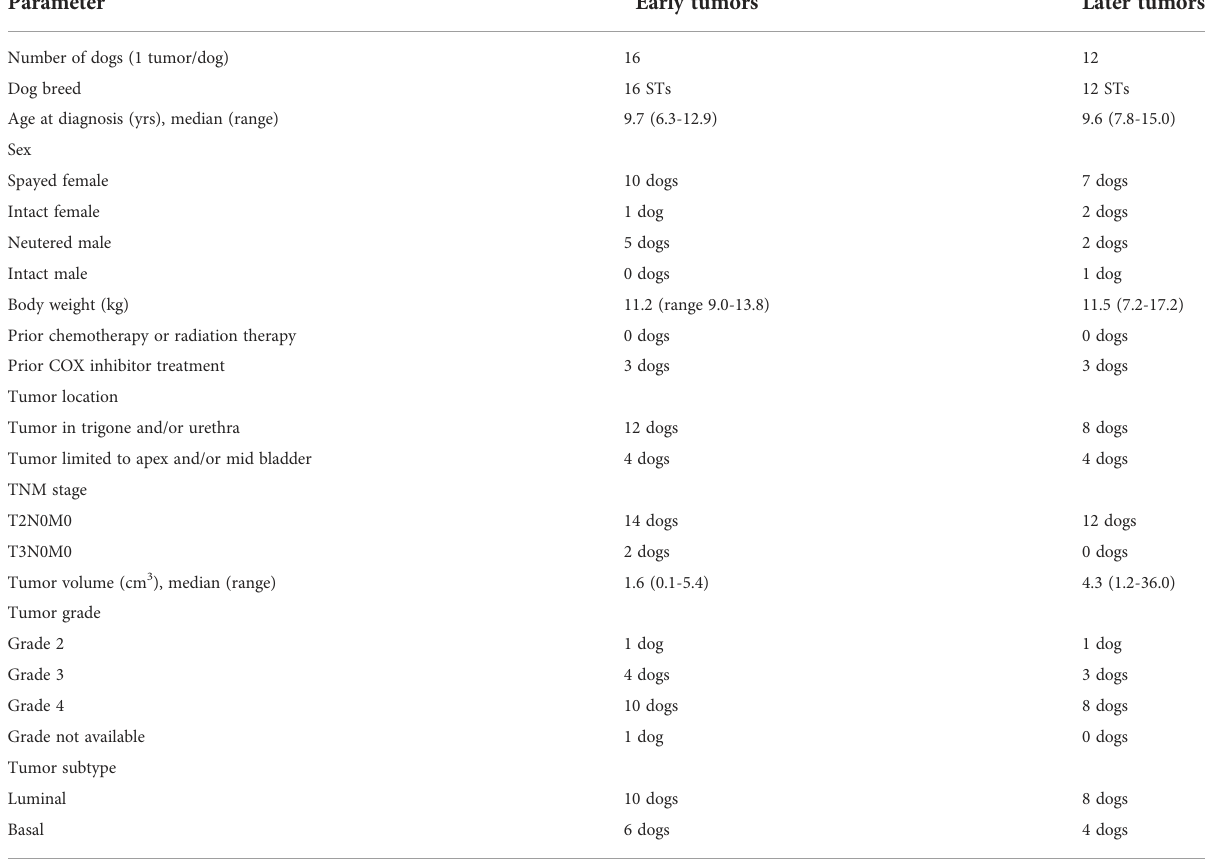
TABLE 4 Dog and tumor characteristics associated with tumor samples used in RNA-seq analyses including “ early ” tumors detected through screening, and “ later ” tumors detected in dogs presenting with lower urinary tract clinical signs and bladder dysfunction.